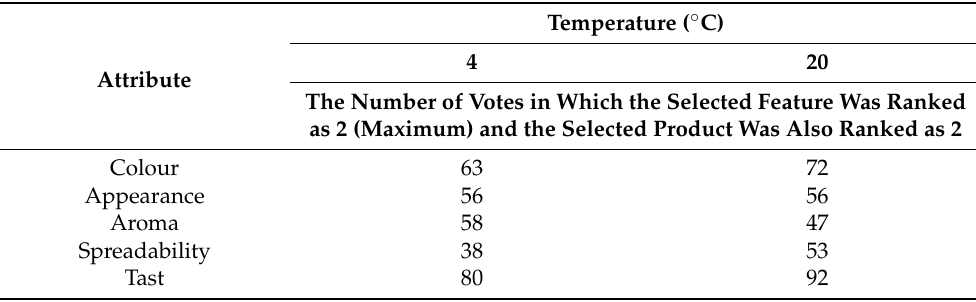
Table 6. Indication of the most desirable milk fat product and indication of the same product having the most desirable given feature (colour, appearance, etc.) (%). Temperature ( ◦ C) 4 20 Attribute The Number of Votes in Which the Selected Feature Was Ranked as 2 (Maximum) and the Selected Product Was Also Ranked as 2 Colour 63 72 Appearance 56 56 Aroma 58 47 Spreadability 38 53 Tast 80